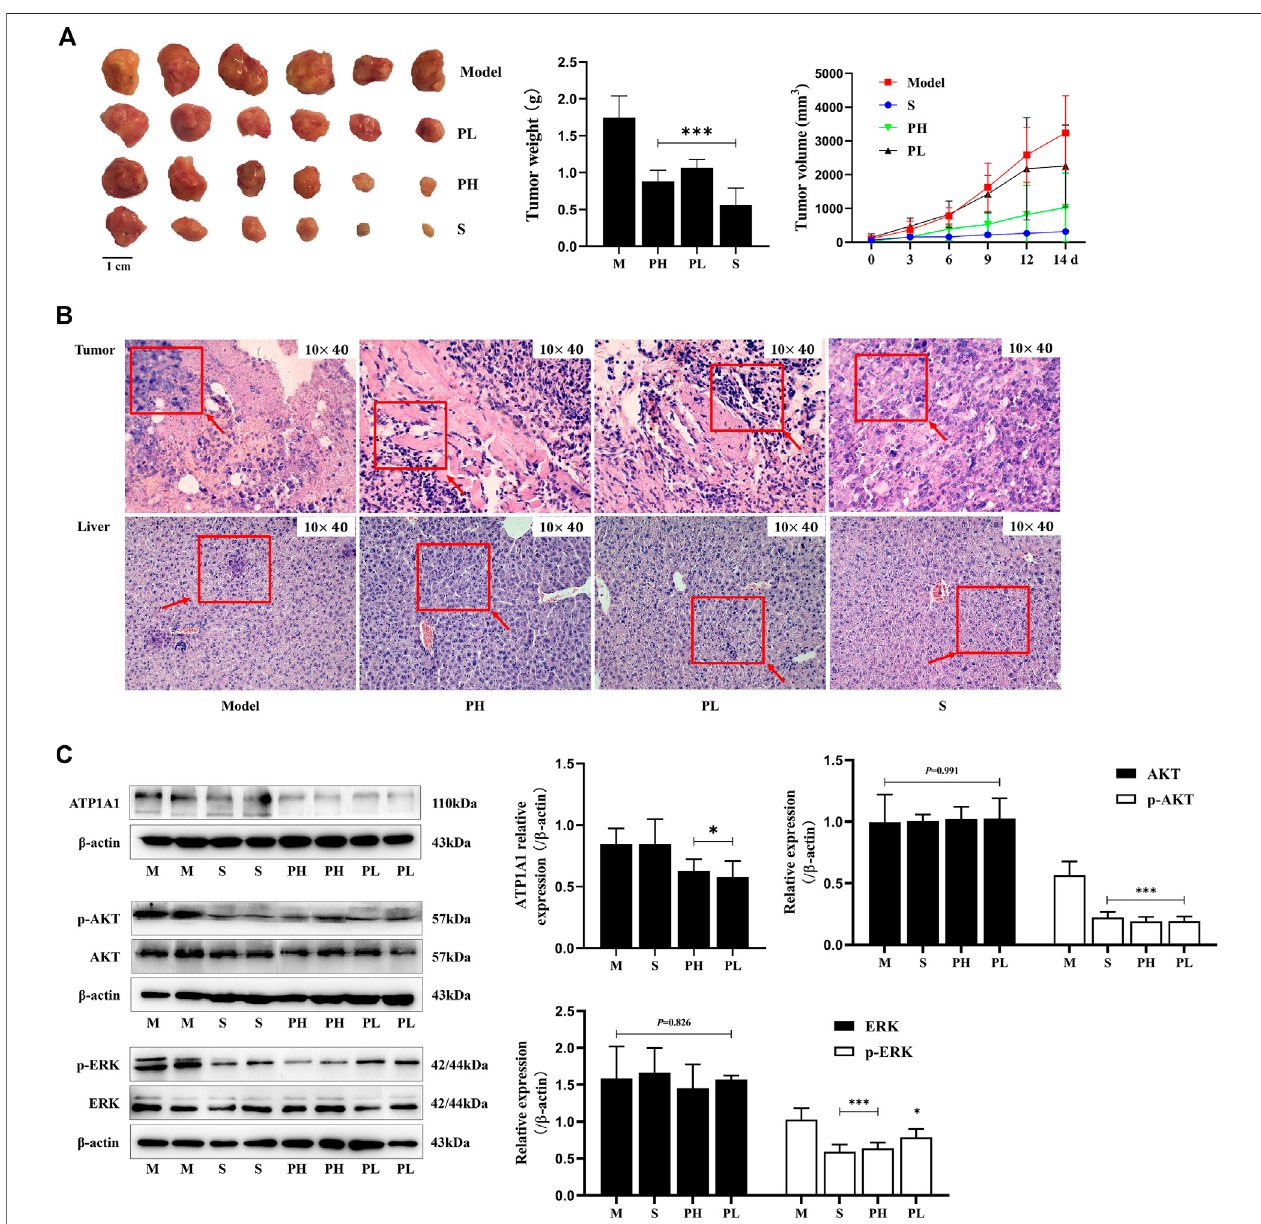
FIGURE 2 | PNS inhibited tumor growth and downregulated the ATP1A1/AKT/ERK signaling pathway. Twenty-four tumor-bearing mice were treated with saline, sorafenib (60 mg/kg), or PNS (50 and 100 mg/kg) by intragastric administration every day for 14 days. (A) The morphologies of tumors were photographed, and tumor weights and volumes were measured. (B) The HE-stained images of tumors were photographed. (C) The Western blot images of ATP1A1, AKT, p-AKT, ERK, and p-ERKandtheirquantitativeanalysisareshown.M:salinegroup;S:sorafenibgroup;PH:100 mg/kgPNSgroup;PL:50 mg/kgPNSgroup.Dataareexpressedas mean ± SD. * p < 0.05, ** p < 0.01, and *** p < 0.001 vs. the model